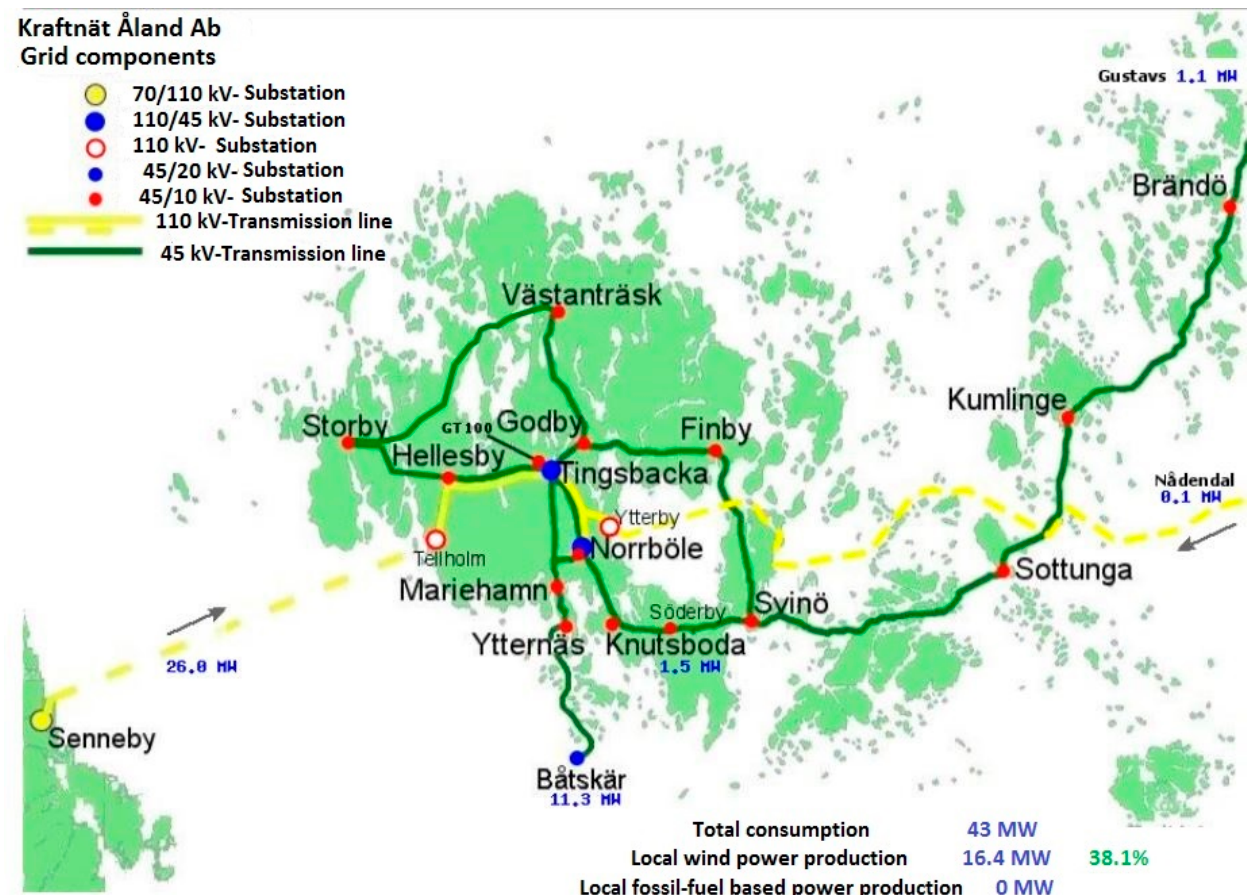
Figure 6. The geographical location and grid structure of the Åland Islands [35].